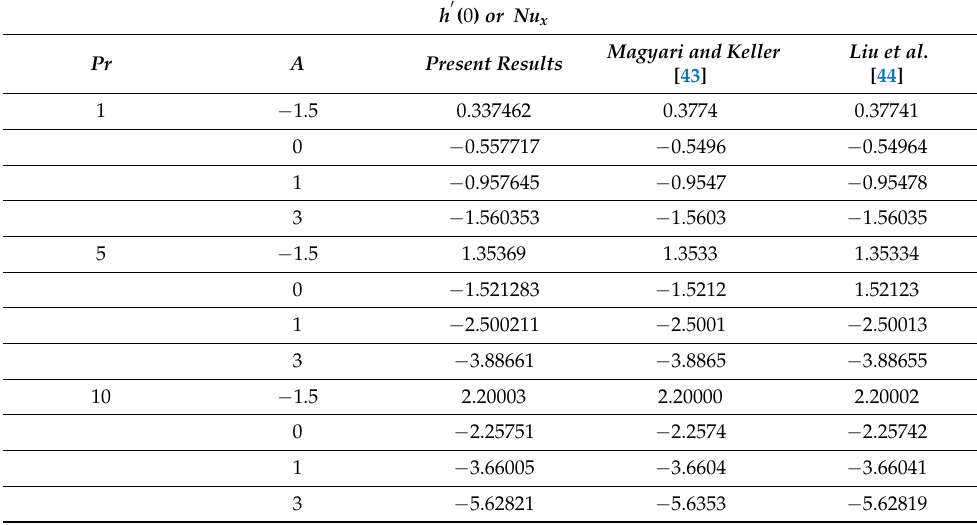
Table 1. Comparison of Nusselt number ( Nu x ) with [43,44] under increasing Prandtl number Pr and temperature exponent A with constant stretching ratio γ = 0.